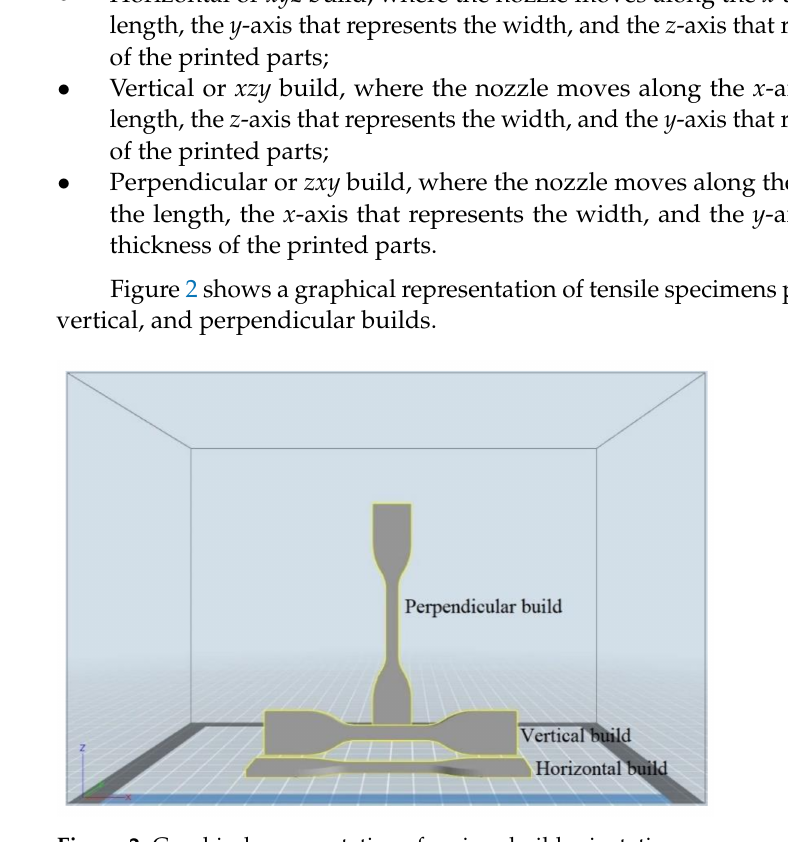
Figure 2. Graphical representation of various build